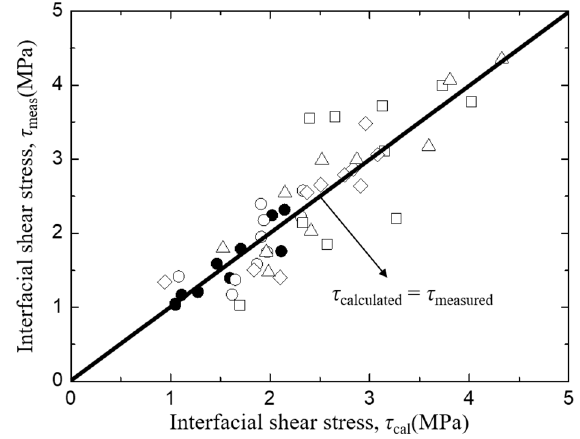
Figure 12. The comparison between measured and calculated interfacial shear strength of Typha spp. /PLLA.